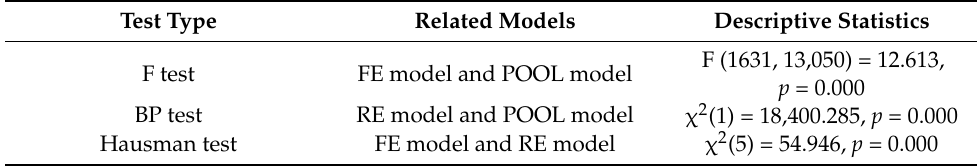
Table 1. Comparable statistics of panel analysis models.